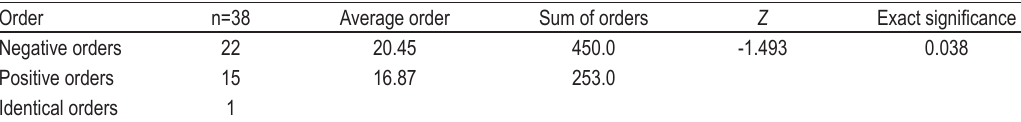
TABLE 2. Depression in elderlies measured by Wilcoxon signed-rank test (1 st measurement versus 6 th measurement)